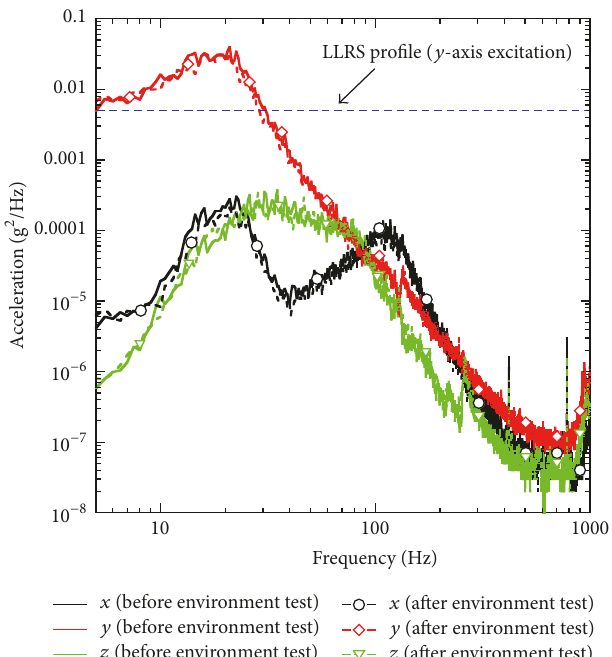
Figure 12: Frequency response spectrum of the RWA isolation system obtained from the low level random sweep (LLRS) test on the 𝑦 -axis before and after the launch vibration tests.